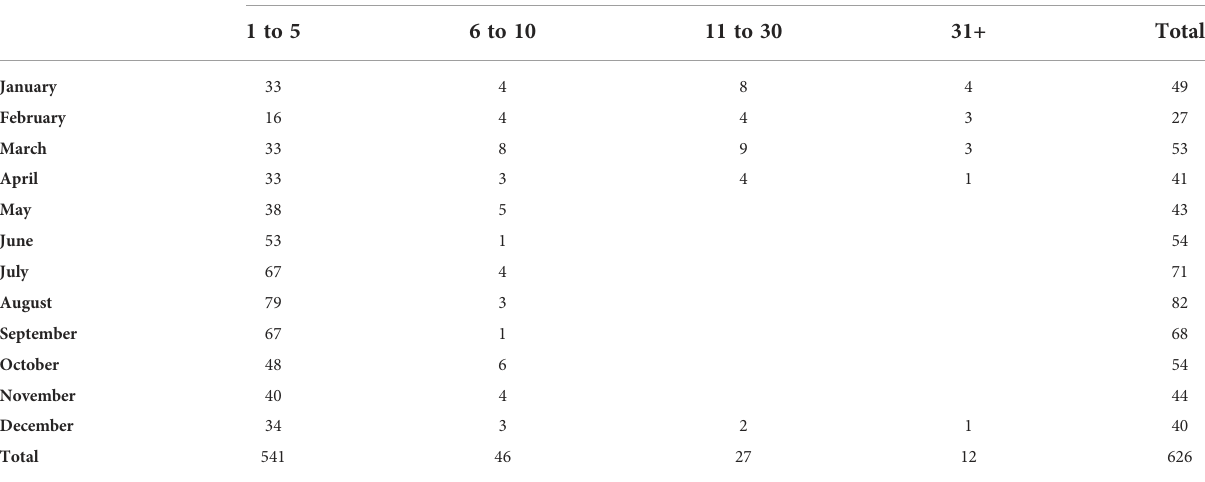
TABLE 1 B.C. Cetacean Sightings Network (BCCSN) data pull for number of harbour porpoise sightings, including number of individuals, reported per month within the Prince Rupert wider study area between 1993 and March 2022. Month Aggregation